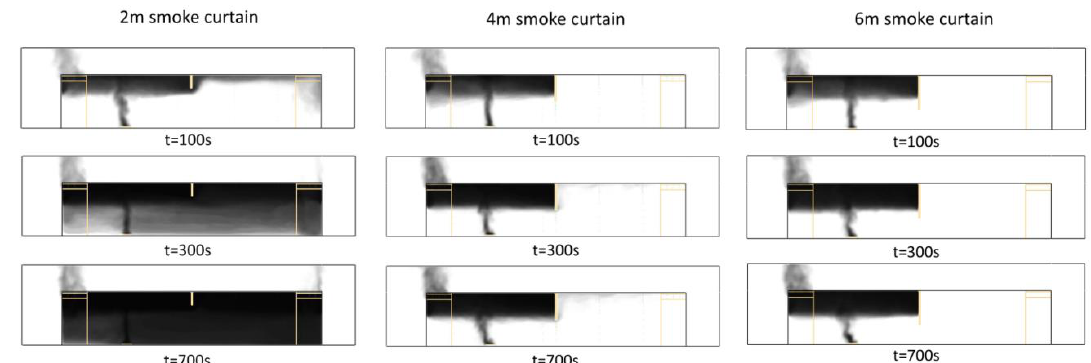
Figure 9. Smoke contour of 2 m (case 3), 4 m (case 2), and 6 m (case 4) smoke curtain case at times: 100 s, 300 s, and 700 s.